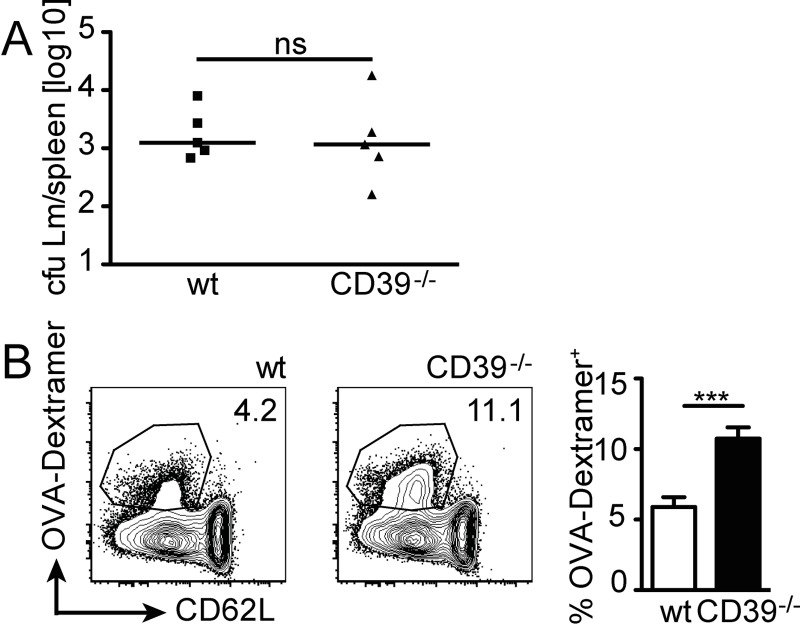
Acquired immune response of CD39-/- mice against L. monocytogenes.Wildtype and CD39-/- mice were i.v. infected with 5×103 Lm. (A) Bacterial burden in spleens was determined at d7 post infection. Combined results for five individually analyzed mice and the median are shown. cfu, colony forming units. Mann Whitney test, ns p>0.05. (B) Wildtype and CD39-/- mice were i.v. infected with 1×105 LmOVA. On day 9 post infection, CD8+ T cells were analyzed with OVA257-264-dextramers. Representative dot plots and frequencies of dextramer+ cells among CD8+ T cells. Bars give the mean ± SEM of seven individually analyzed mice. Combined data of two experiments. Unpaired t test, *** p<0.001.